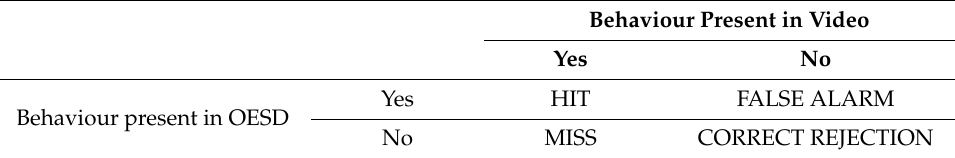
Table 2. Signal detection paradigm for Operator Event Sequence Diagram